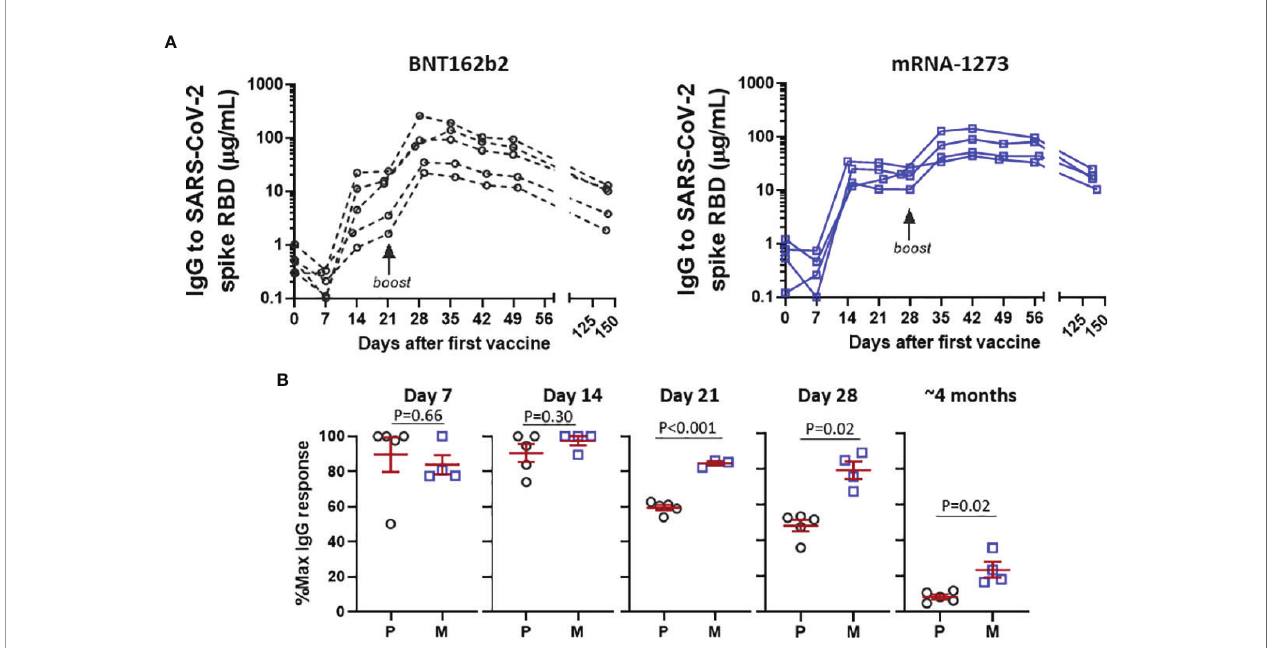
FIGURE 3 | Detailed analysis of response to BNT162b2 P and mRNA-1273 M in subjects with weekly sampling. (A) Early IgG response following fi rst and second dose of BNT162b2 or mRNA-1273 in longitudinally monitored subjects. (B) Levels of IgG following the second vaccination expressed as % in relation to post-boost peak IgG level, strati fi ed by days after second vaccine. Data in (B) presented as GM with 95% CI and comparisons with Mann-Whitney U